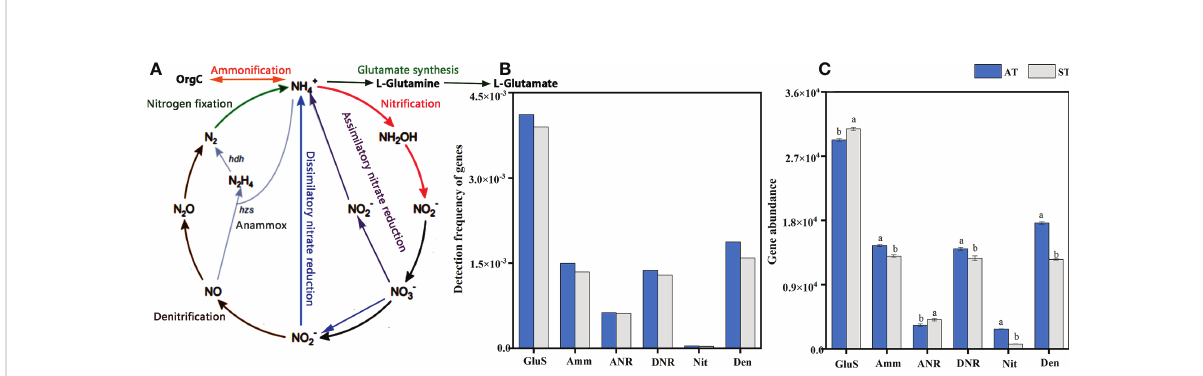
FIGURE 2 An overall schema illustrating the N-cycle processes (A) , detection frequency (B) and abundance (C) of functional genes for each N-cycle with different acidity of tea soils. AT, tea soil with a pH of 3.75; ST, tea soil with a pH of 5.26. GluS, glutamate synthesis; Amm, ammoni fi cation; ANR, assimilatory nitrogen reduction; DNR, dissimilatory nitrogen reduction; Nit, nitri fi cation; Den, denitri fi cation. Bars indicate standard error of the mean (n = 3). Different lowercases represent signi fi cant differences at P < 0.05